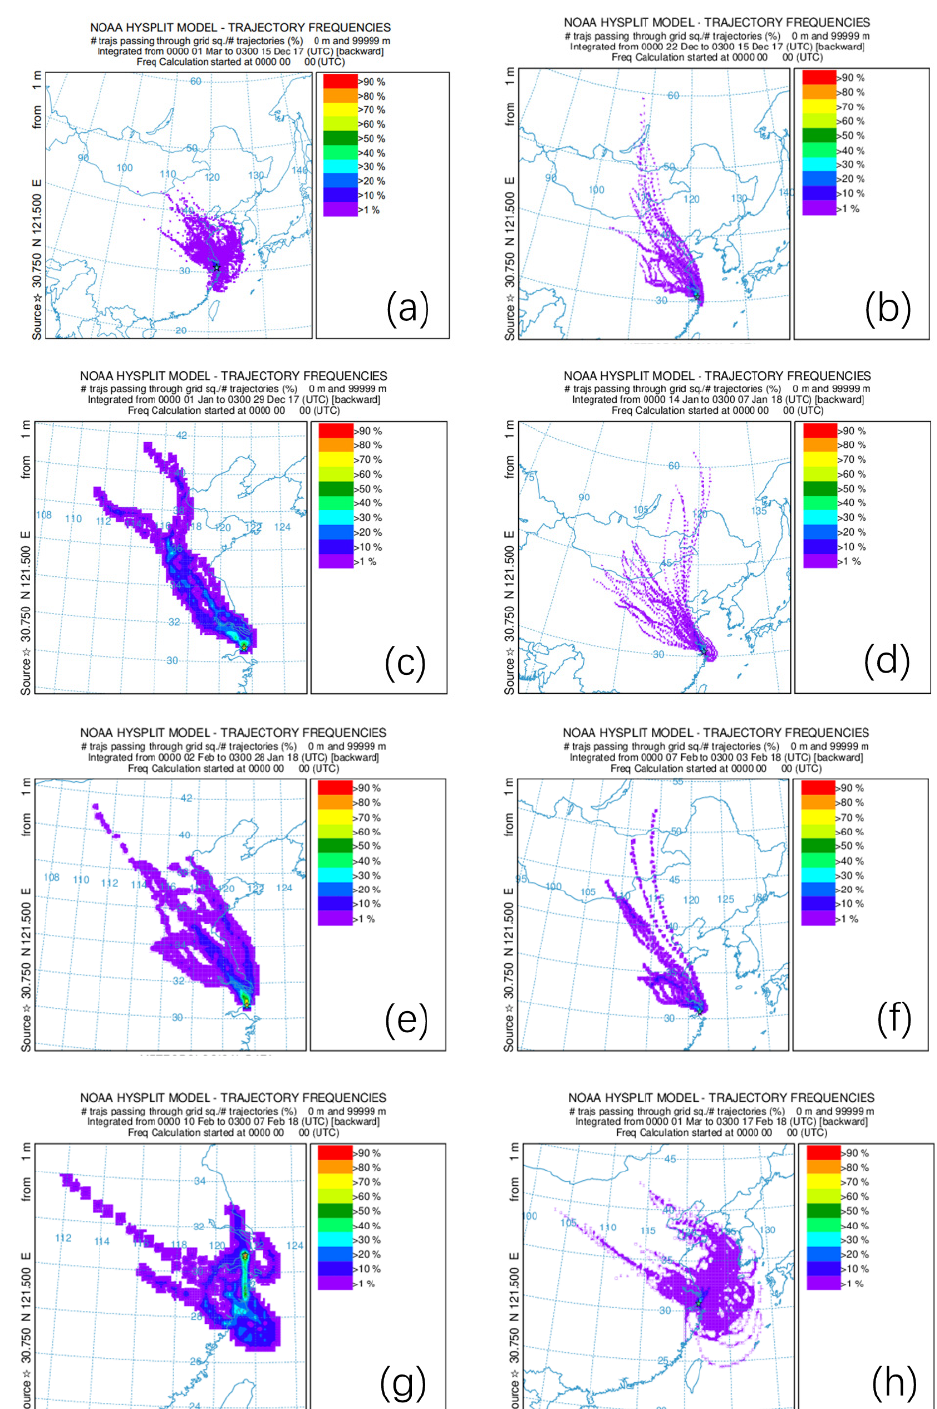
Figure 8. The backward trajectory frequency of this campaign. ( a ) is the whole campaign; and from ( b – h ) is in chronological order: 15–22 December 2017 clear period; 29 December 2017–1 January 2018 haze period; 7–14 January 2018 clear period; 28 January 2018–2 February 2018 haze period; 3–7 Feb- ruary 2018 clear period; 7–10 February 2018 haze period; 17 February 2018–1 March 2018 clear pe- riod, respectively.